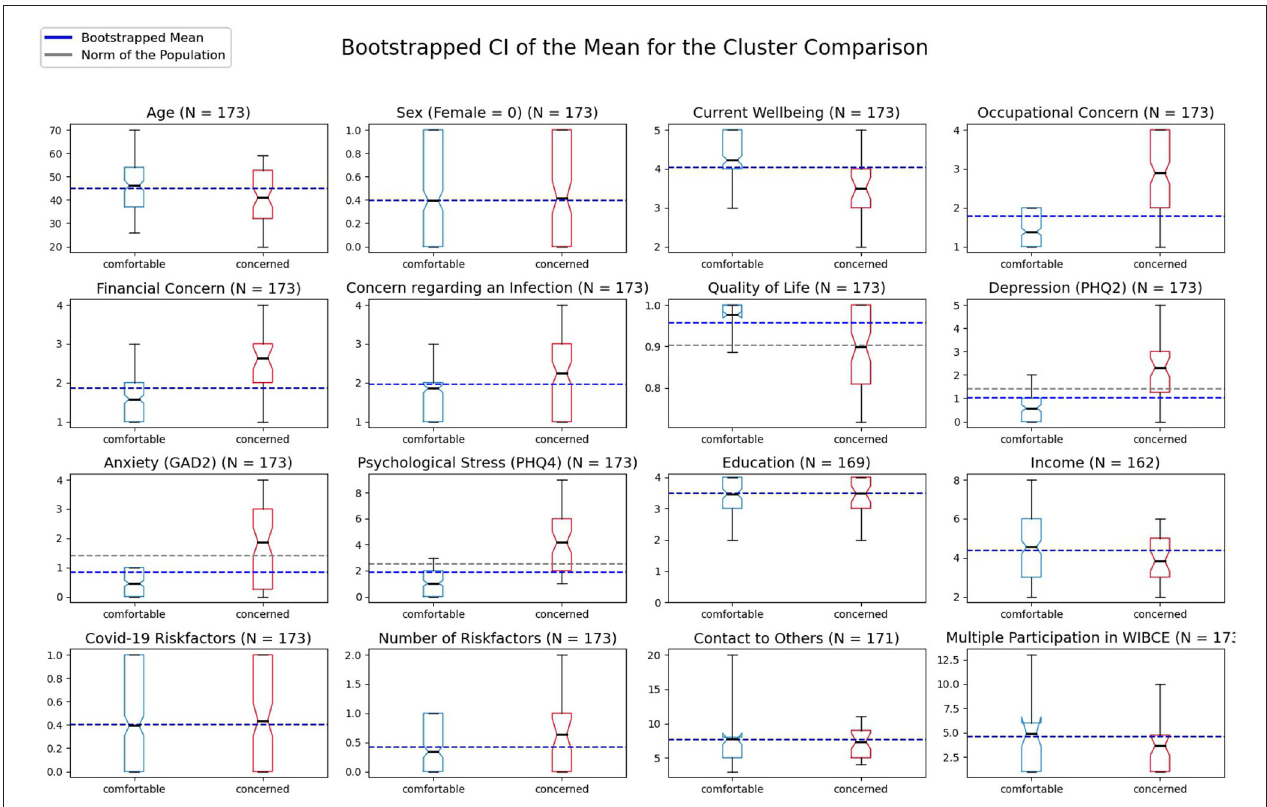
FIGURE 1 | Bootstrapped means and 95% confidence intervals (CI) of the two clusters comfortable (blue) and concerned (red) for each variable. Notches in the boxes of the plot visualize the upper and lower boundary of the CI with the black small line in the box representing the mean of each cluster and the blue line representing the overall mean of the clusters. The gray line represents a population norm as reference with M = 0.902 for the EQ-5D-5L ( 28), M = 1.4 for the PHQ-2 ( 26), M = 1.4 for the GAD-2 (25), and M = 2.5 for the PHQ-4 (24). The box comprises 50% of the distribution from the 25th to the 75th quartile. The ends of the whiskers represent the 5th and 95th quartile of the